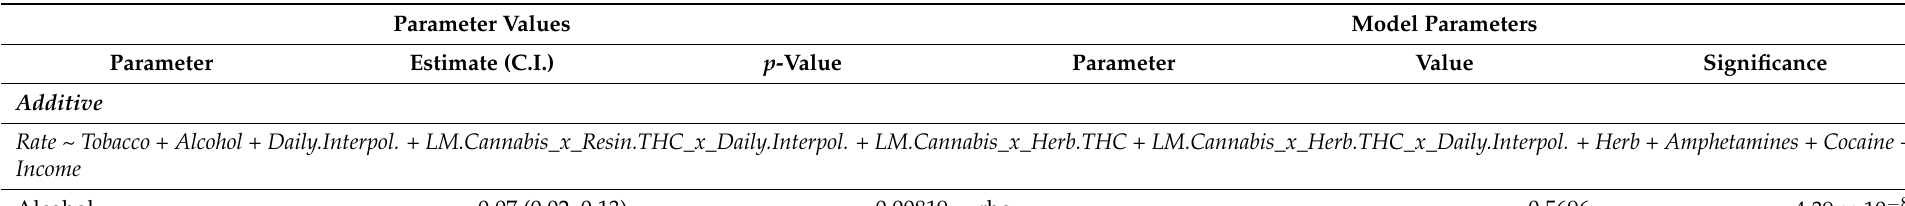
Table 6. Multivariate Geospatial Regression for Patau Syndrome (Trisomy